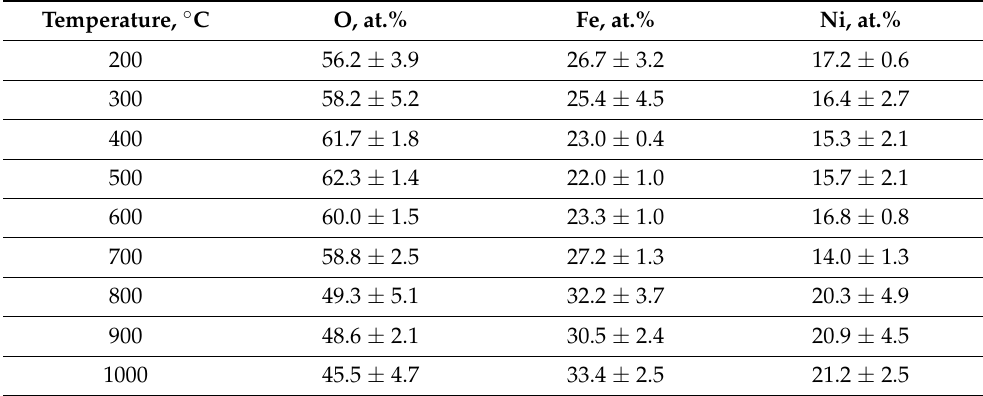
Table 1. Results of energy-dispersive analysis. Temperature, ◦ C O, at.% Fe, at.% Ni, at.%